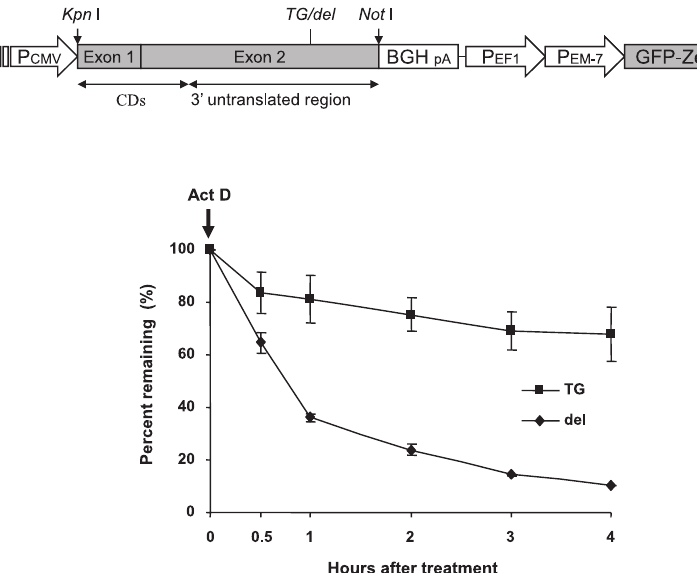
Figure 5. Dinucleotide Deletion at P1527 Destabilizes CD24 mRNA The top panel depicts vector constructs used in the analysis. The CD24 cDNA and the GFP-Zeocin have a different promoter and poly-A site cassette, respectively. Vectors with different haplotypes, CD24 TG and CD24 del , were used to transfect CHO cells. The lower panel shows the kinetics of mRNA degradation. The amount of CD24 mRNA was quantified using RT-PCR. Actinomycin D treatment was administered at 48 h after transfection, and the total RNA was extracted at 0, 0.5, 1, 2, 3, and 4h after actinocmycin D treatment. The relative amount of CD24 mRNA was calculated as the percentage of untreated mRNA. A significant difference in CD24 mRNA degradation was observed between CD24 TG and CD24 del haplotypes ( p , 0.0001, Fisher’s PLSD test). Error bars represent the standard deviation of mean. Data shown have been repeated twice.